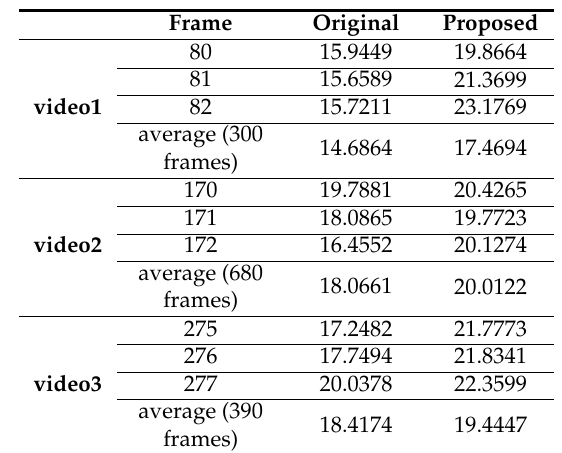
Table 2. Comparison of the original and stabilized videos in the sense of PSNR values.